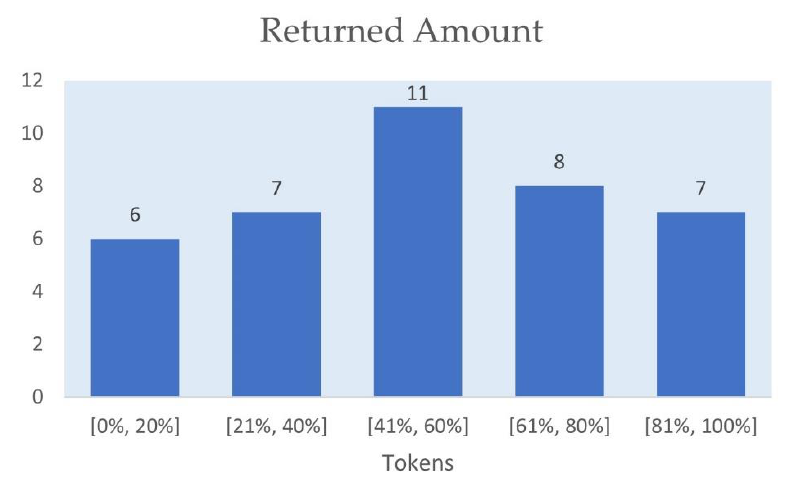
Figure 15. Distribution of returned amounts in the trust game, %.